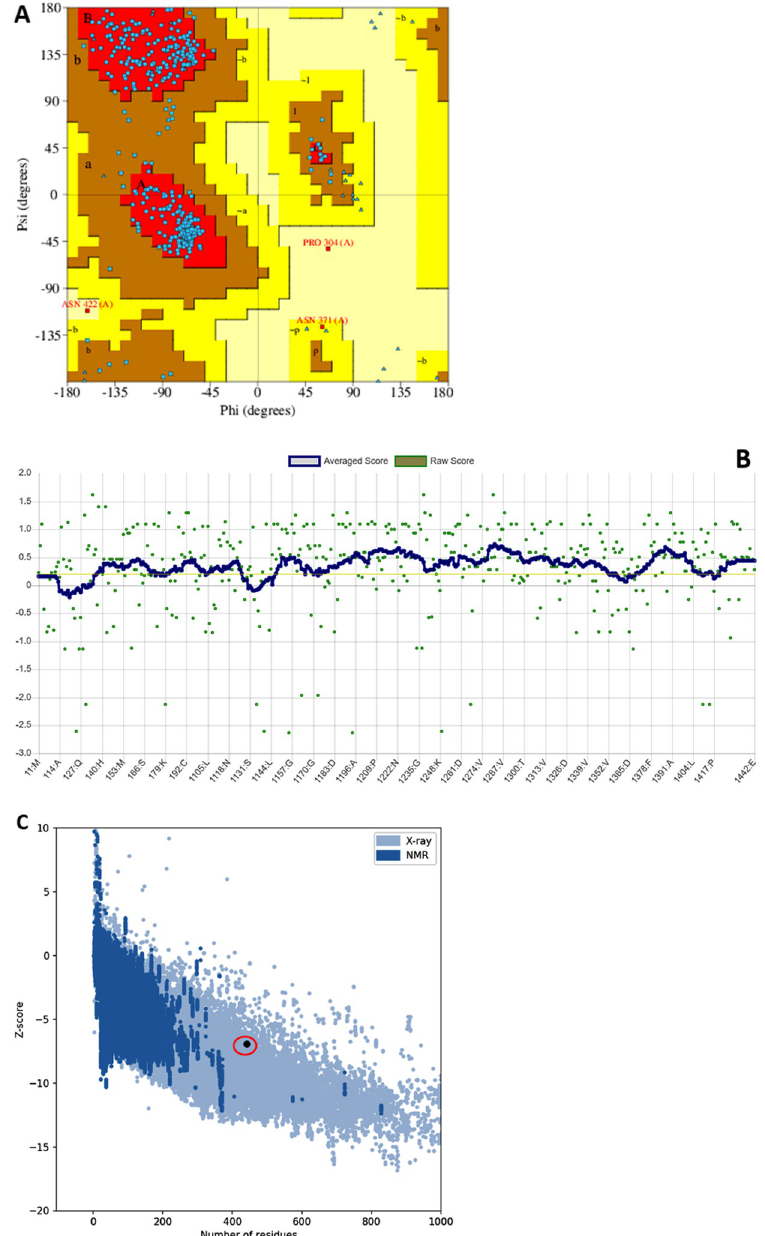
Fig 5. (A). Ramachandran plot of CAASPR-HM49 subtilisin like protease refined model. Above 90% residues were spotted in most favoured regions and over 8% residues were localized in additional allowed regions. Presence of residue over 90% in most favoured regions is the recognition for a good model. PDBsum was used for producing this plot. (B). 3D/1D profile of refined CAASPR-HM49 subtilisin like protease model. Above 81% residues displayed a score equal to or greater than 0.2 due to which the good model quality is strongly perceptible. (C). Z-score plot portraying how well the refined model aligns with experimentally generated structures. This plot compares the algorithm-generated models with X-ray diffraction and NMR solved protein structures having amino acid length similar to modelled protein. If the modelled protein lies outside the shaded area, then the model is probably integrated with errors. From the location of our modelled protein on this plot, it is highly evident that it is free from probable errors. In other words, the overall quality score of CAASPR-HM49 subtilisin like protease model is well within (not outside) the